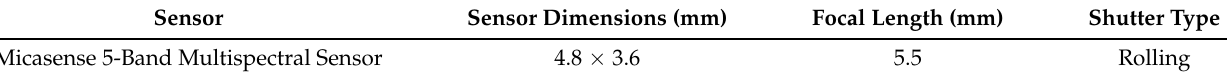
Table 2. Micasense 5-band multispectral sensor specifications.